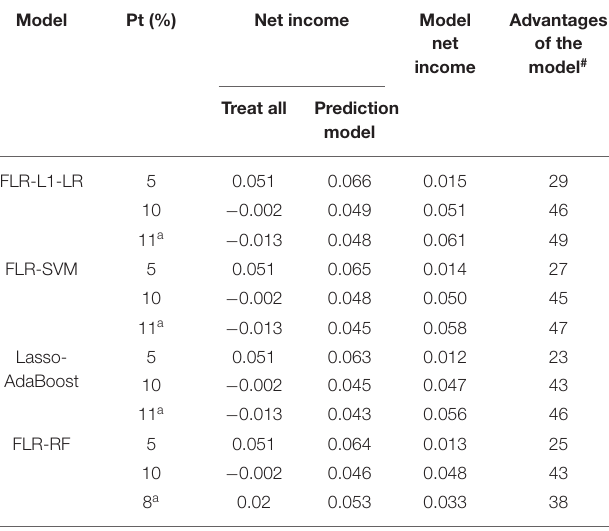
TABLE 3 | Comparison of clinical effectiveness of models.